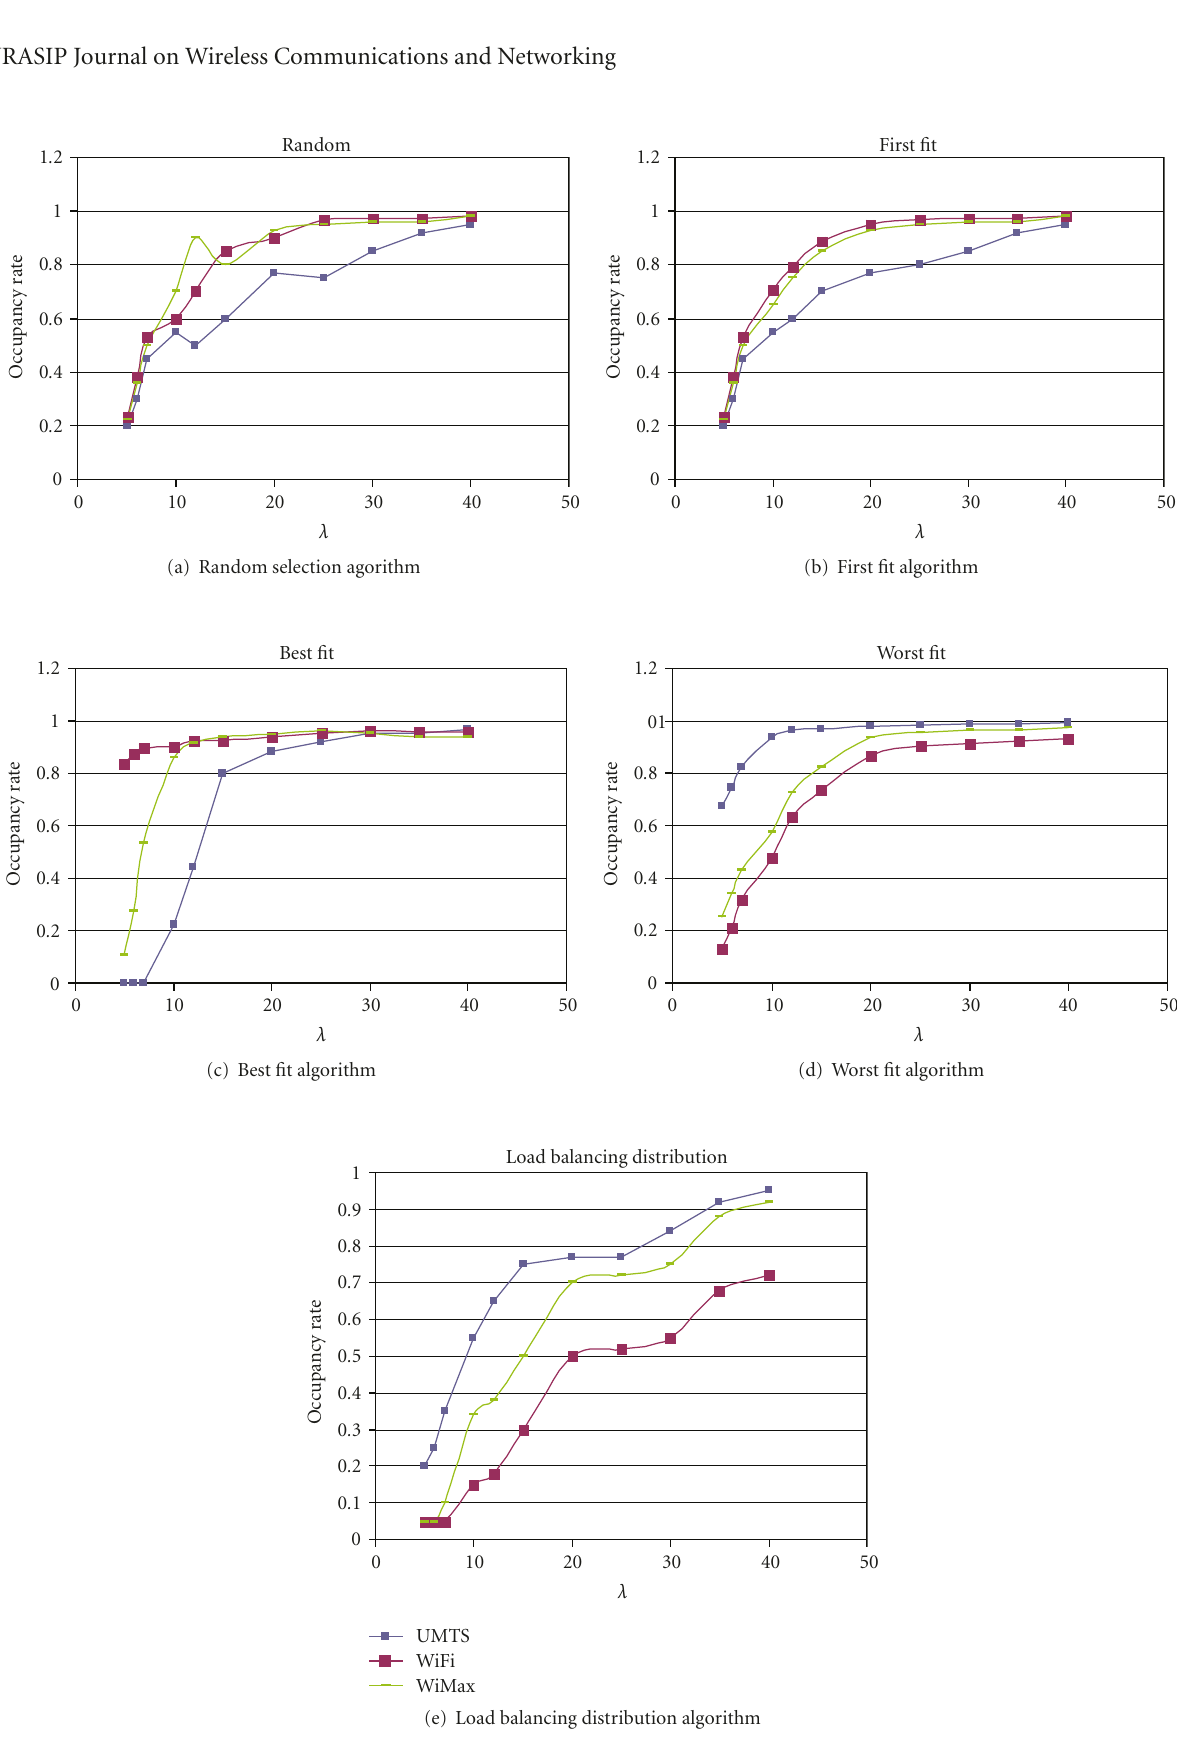
Figure 9: Simulation results showing the occupancy rate versus arrival